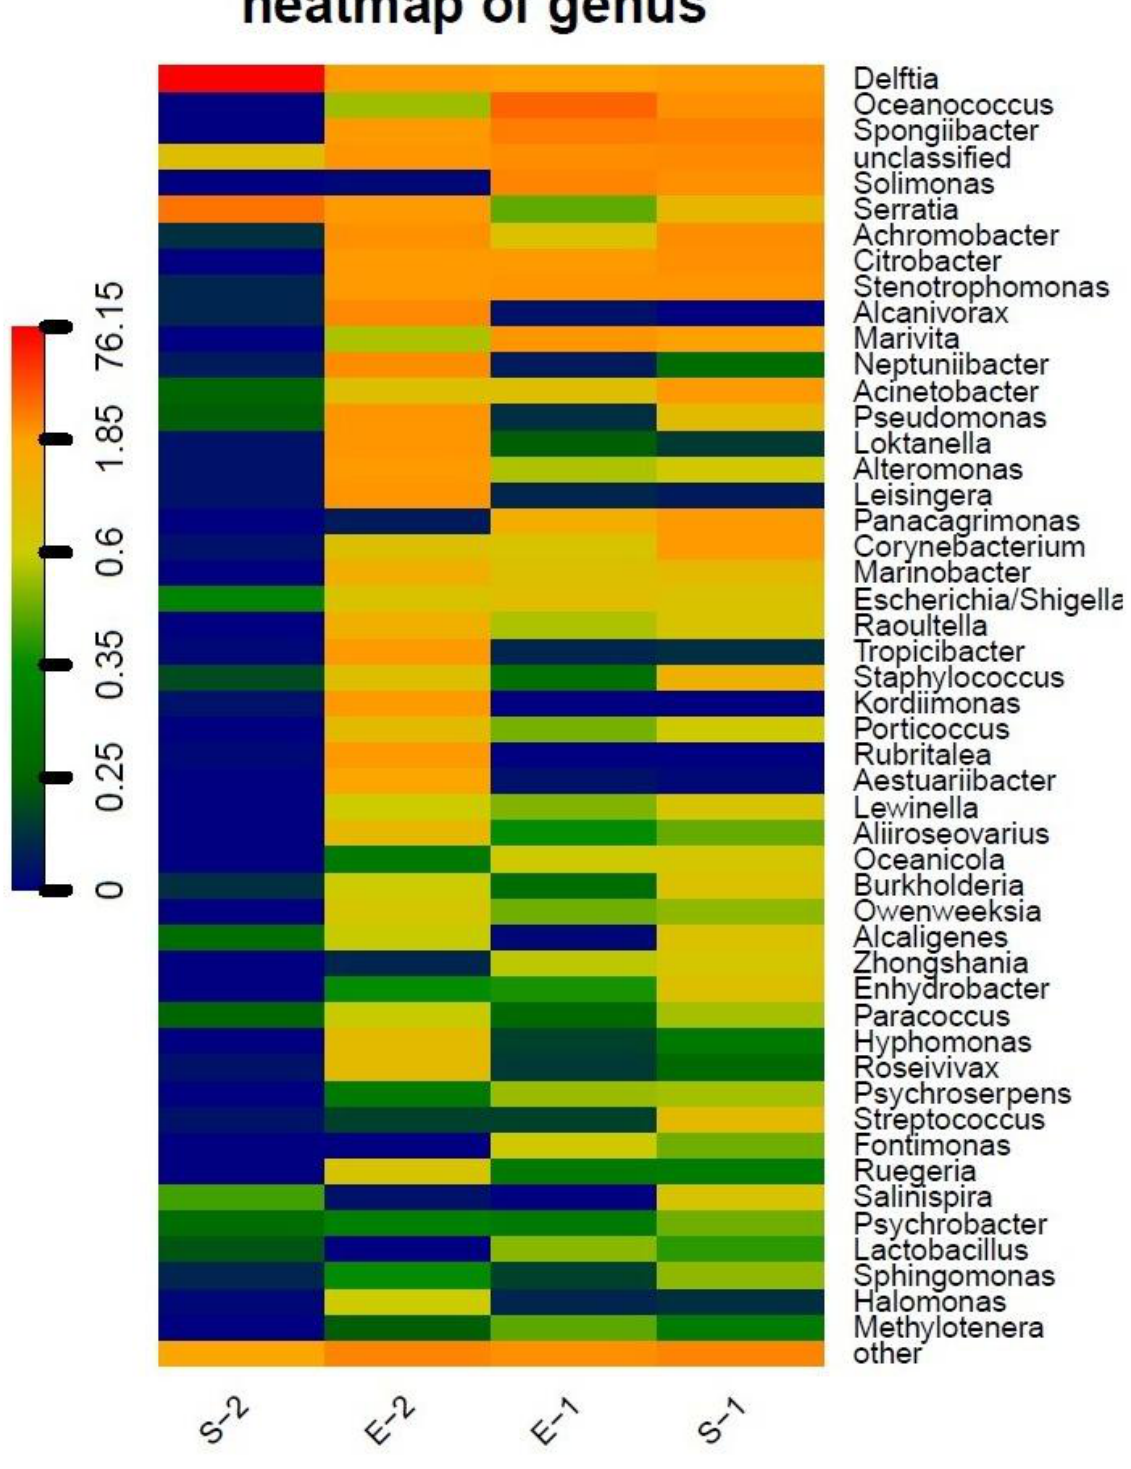
Fig. 5. Bacterial genera abundance heat map. The abundance of species is plotted with a species abundance matrix. Each column represents a sample. The rows represent the community structure. The color block represents the relative abundance of the species. The more red the color, the higher the relative abundance, and the more blue the color, the lower the relative